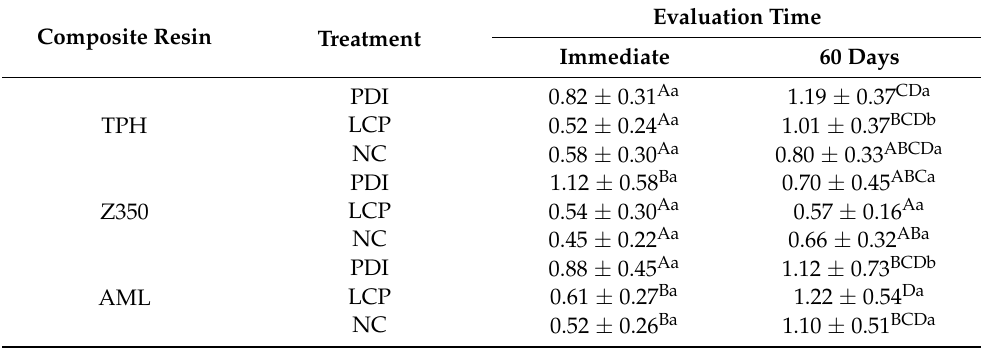
ANOVA: time ( p < 0.001); treatment ( p < 0.001); resin ( p < 0.001); time × treatment ( p = 0.008); time × resin ( p < 0.001); resin × treatment ( p = 0.448); time × resin × treatment ( p = 0.037). Šid á k correction ( p ≤